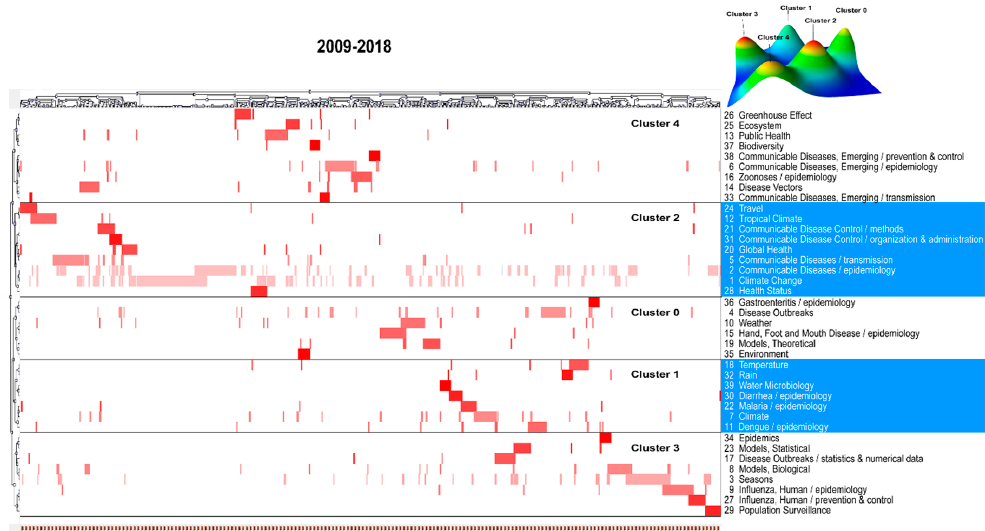
Figure 4. Mountain and matrix visualization of biclustering of highly-frequent major MeSH/subheading combination terms and articles on climate change and infectious diseases from 2009 to 2018.